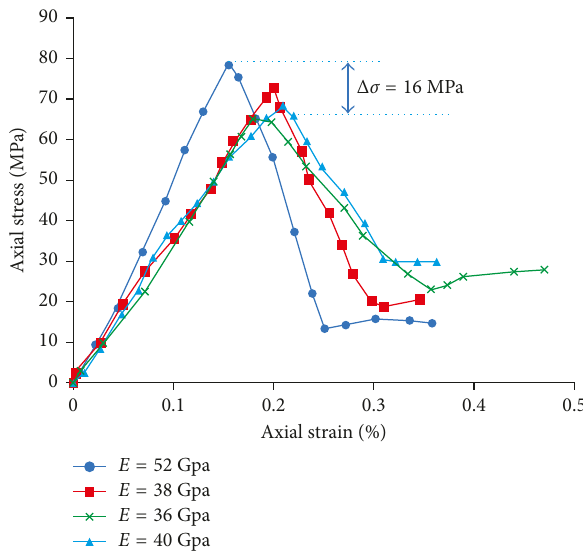
Figure 10: The spatial distribution of mechanical properties ( m 6). (cid:29)